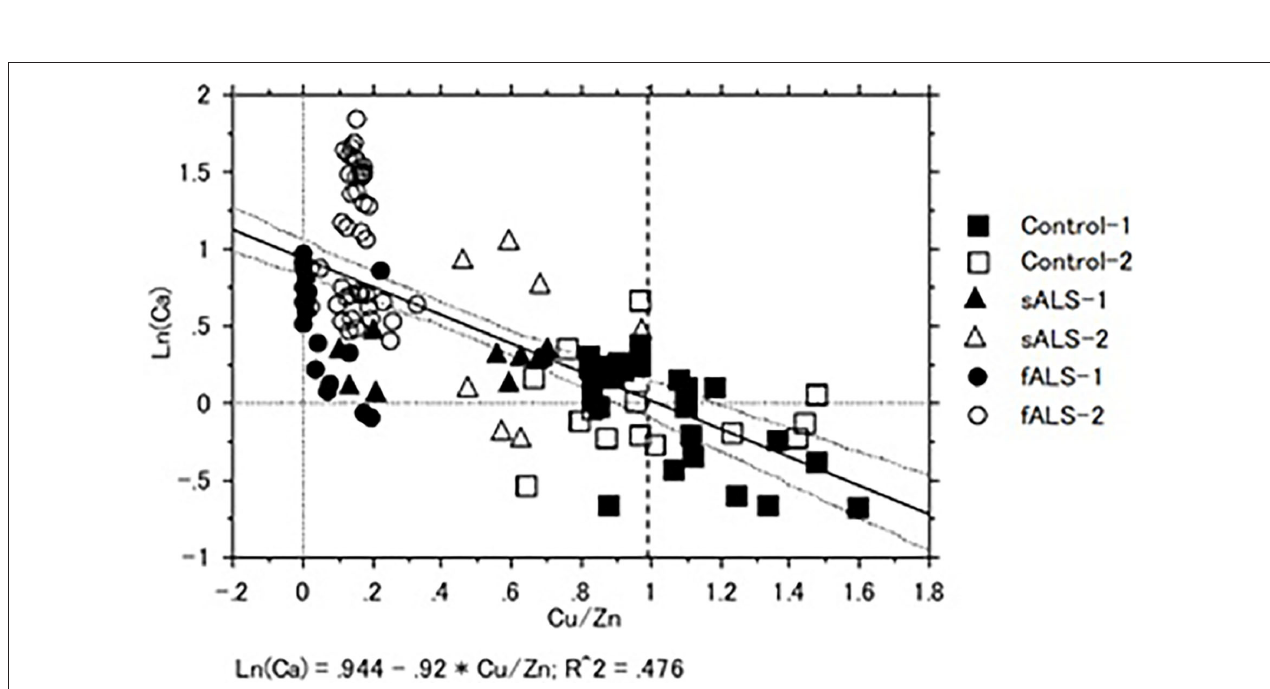
FIGURE 6 | Correlation of Cu/Zn ratios and Ca contents in the lumber spinal cord tissues of sALS, fALS and control cases. Overall, Ln (Ca) = 0.944–0.92*Cu/Zn ( n = 118, r = 0.690, R 2 = 0.476, p < 0.0001).